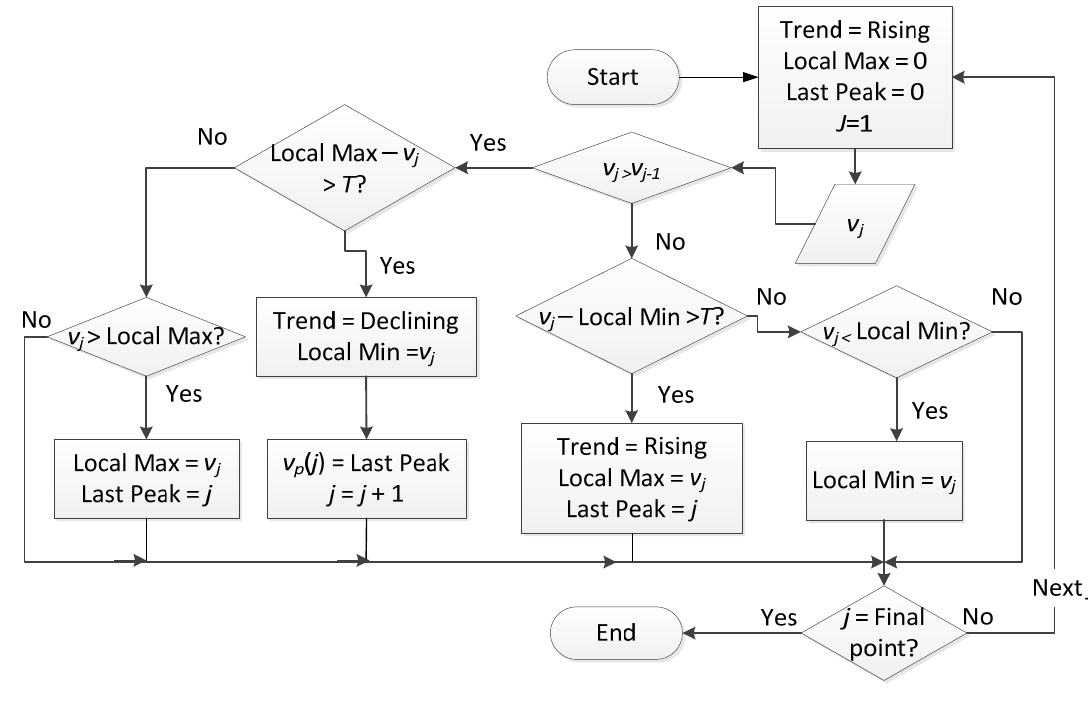
Figure 11. Peak detection flowchart in the vertical